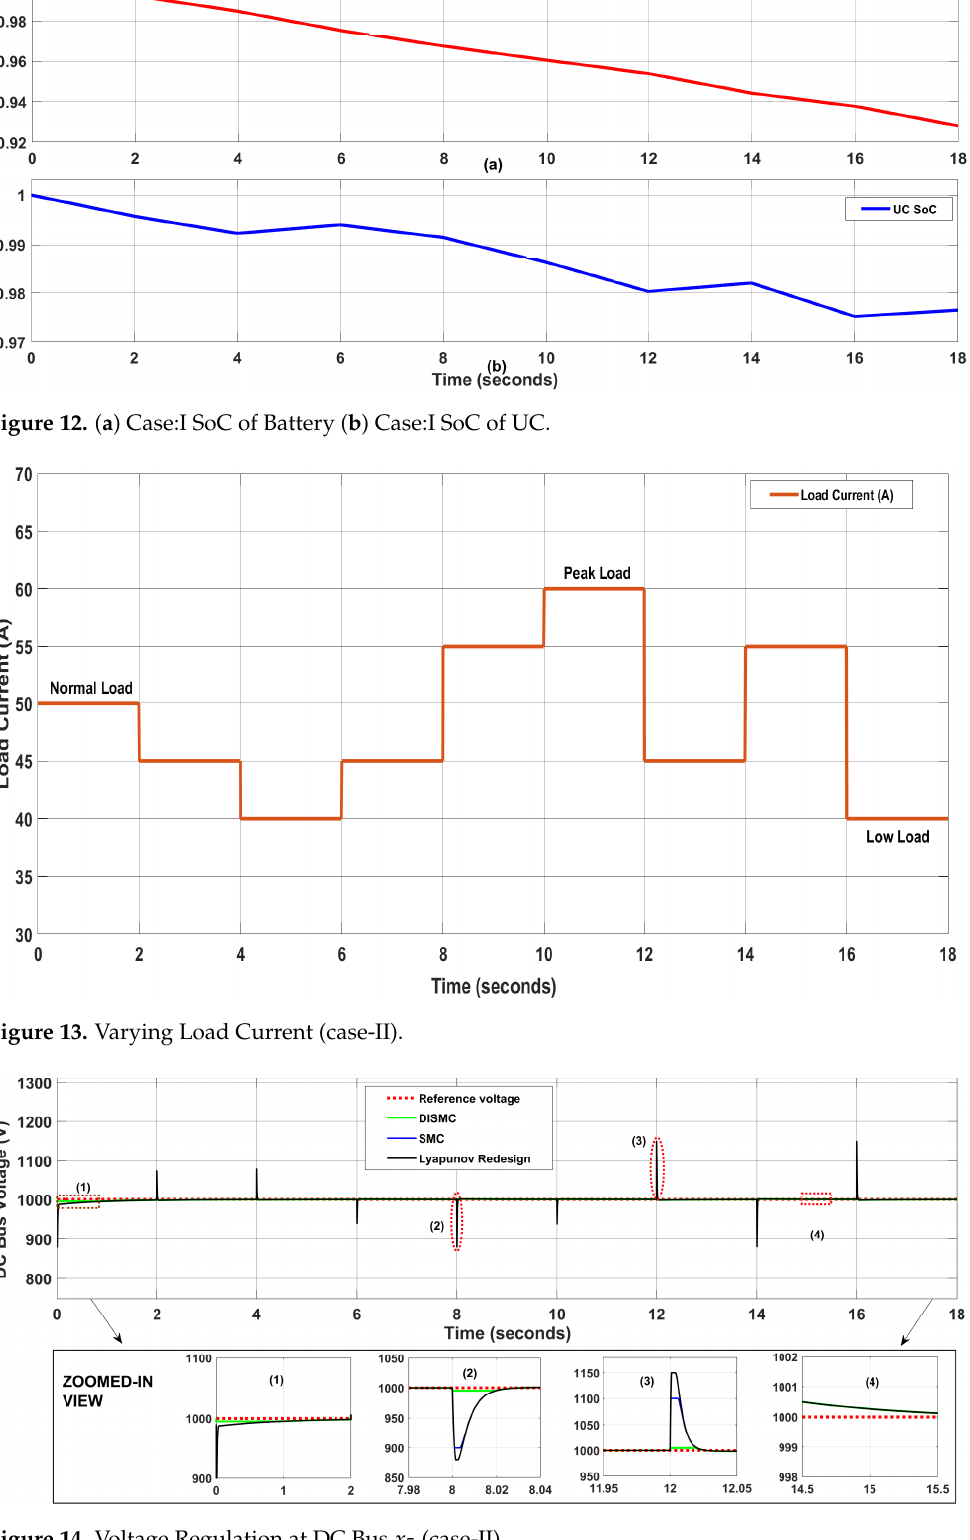
Figure 14. Voltage Regulation at DC Bus x 5